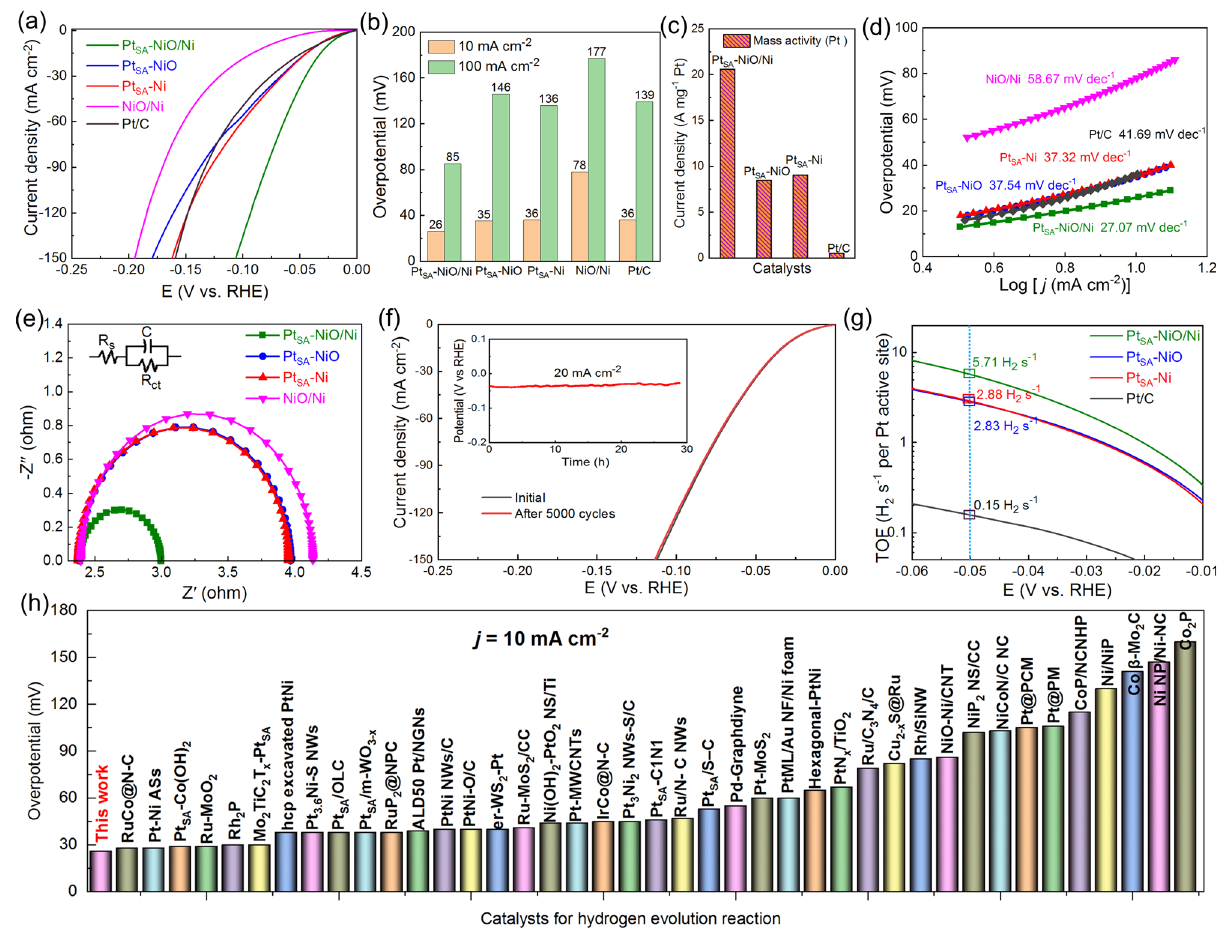
Fig. 5 Electrocatalytic alkaline HER performances of the catalysts in 1-M KOH electrolyte. a HER polarization curves of Pt SA -NiO/Ni, Pt SA -NiO, Pt SA -Ni, NiO/Ni, and Pt/C. b The comparison of overpotentials required to achieve 10 and 100 mA cm − 2 for various catalysts. c The mass activity of the Pt-based catalysts. d Corresponding Tafel slope originated from LSV curves. e EIS (Electrochemical Impedance Spectroscopy) Nyquist plots of the catalysts. f Stability test of Pt SA -NiO/Ni through cyclic potential scanning and chronoamperometry method (inset in f ). g TOFs plots of the Pt-based electrocatalysts. h Comparison of the HER activity for Pt SA -NiO/Ni with reported catalysts, originating from Table